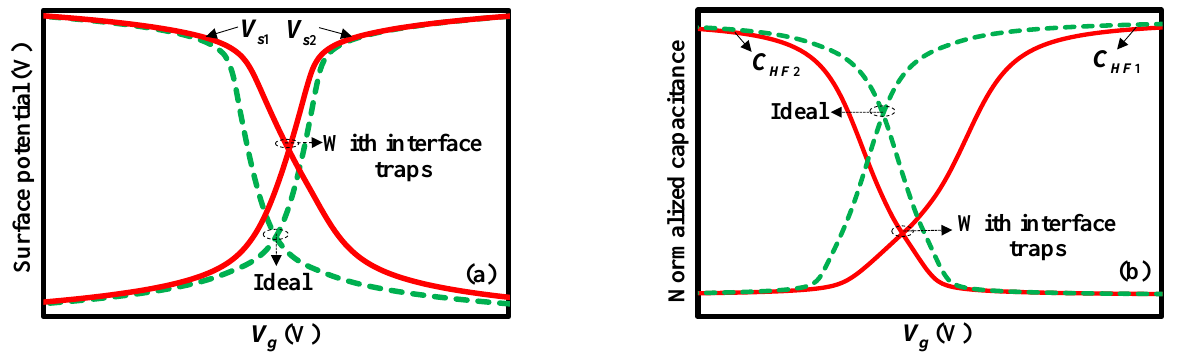
Figure 8. Influence of interface traps on ( a ) surface potentials and ( b ) high-frequency capacitance – voltage curves in the upper and lower MIS structures of the stacked bonding structure.